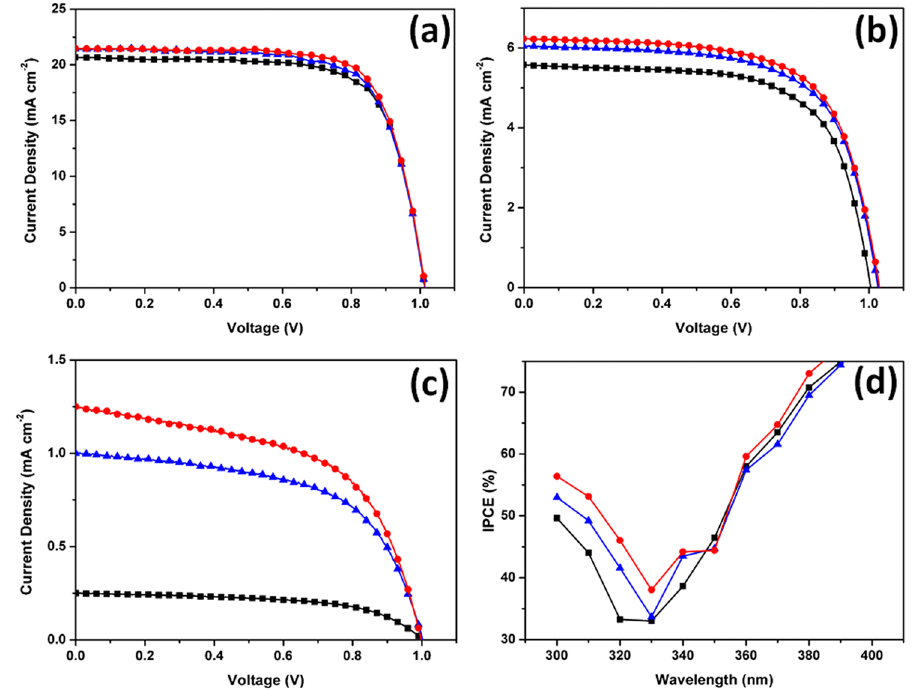
Figure 6. Photovoltaic performance. The comparative photovoltaic performances of standard perovskite solar cell (black), with phosphor monolayer film (blue) and with Au@Y 2 O 3 :Eu 3 + dual-hybrid film (red). I-V curve under 1-sun ( a ), below 400 nm ( b ) and below 300 nm of wavelength ( c ), and IPCE ( d